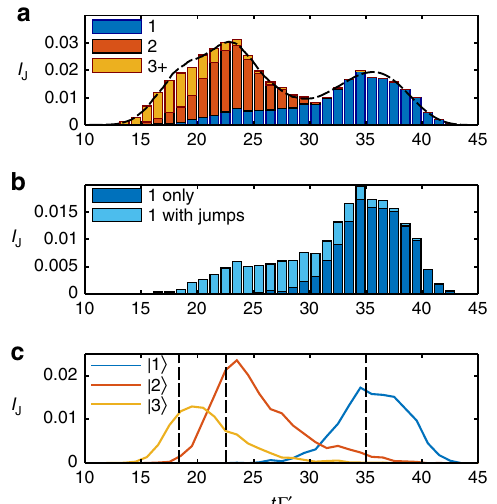
Fig. 5 VIT quantum jumps statistics. a Stacked bar graph of quantum jumps into the output channel over the 20000 quantum trajectories used in Fig. 4. The height of each bar, I J , is the average number of jumps occurring in the time bin de fi ned by the bar ’ s width, in this case 1/ Γ ′ . The bars are then divided into three categories by classifying each jump according to how many jumps into the output channel occur for a particular trajectory (1, 2, or 3 or more). Jumps from trajectories where there are a higher number of photons emitted into the output channel are seen to occur earlier. For comparison the dashed black line shows the output intensity from Fig. 4. b Stacked bar graph for quantum jumps from trajectories where only a single photon is detected in the output of the waveguide. These jumps are then divided into jumps that are not accompanied by any other jump into other channels, and those that are. We see that the tail of photons detected earlier are due to trajectories where 2 or more photons entered the medium but all but one were lost into other channels. c Post-selection of trajectories to fi nd evolution for Fock state input. By selecting only trajectories where there were a total of 1 (blue), 2 (red), or 3 (yellow) jumps into any channel we can reconstruct the intensity output for the corresponding input